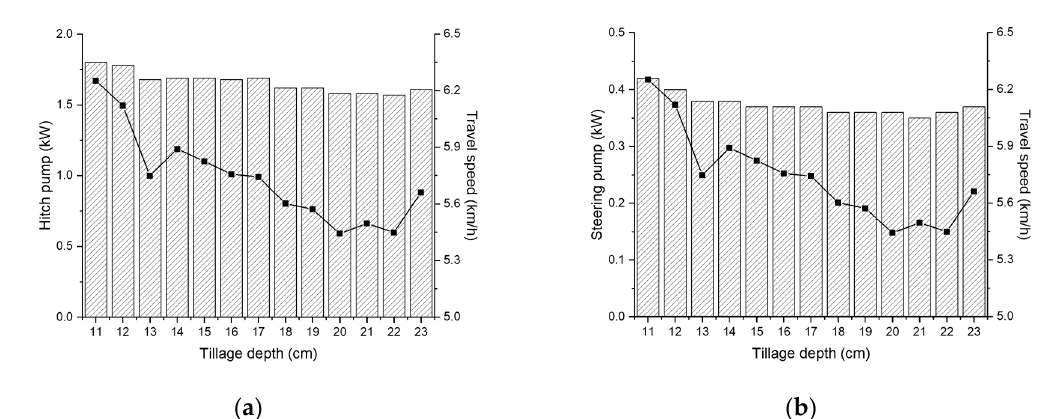
Figure 13. Overall mean power requirements of hydraulic pump according to tillage depth: ( a ) power requirements of hitch pump, and ( b ) power requirements of steering pump. Table 11. Descriptive statistics of hitch pump power (kW) according to tillage depth. Tillage Depth (cm)